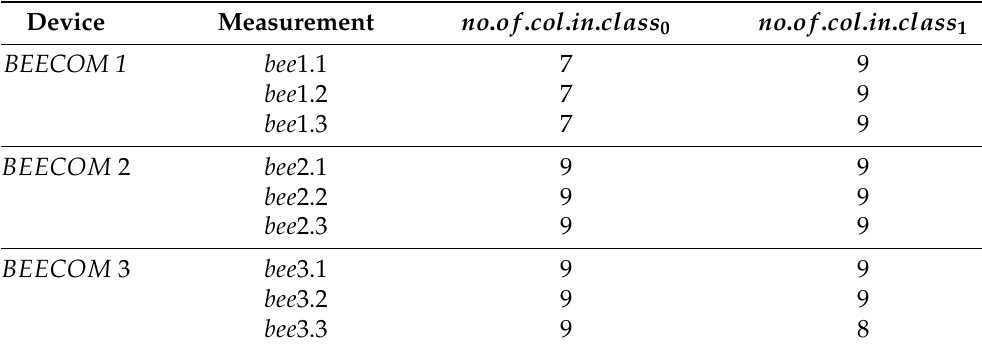
Table 5. The number of bee colonies correctly examined during each test. Only this number of colonies was used in the tests. no . of . col . in . class i = number of colonies available in class i , i ∈ { 0,1 } . Device Measurement no . of . col . in . class 0 no . of . col . in . class 1 BEECOM